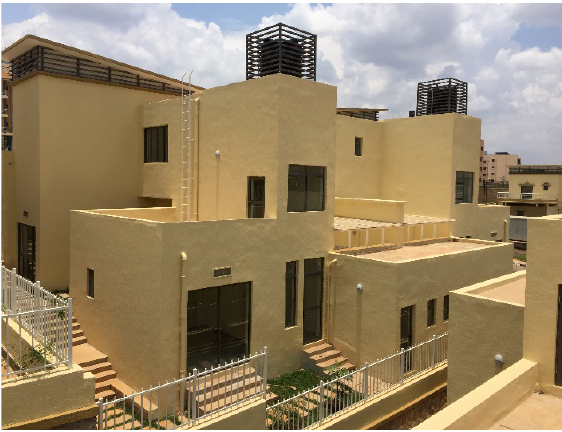
Figure 57. The Umudugudu Kigali Vision: Twin houses; front yard. Photograph by Manlio Michieletto.